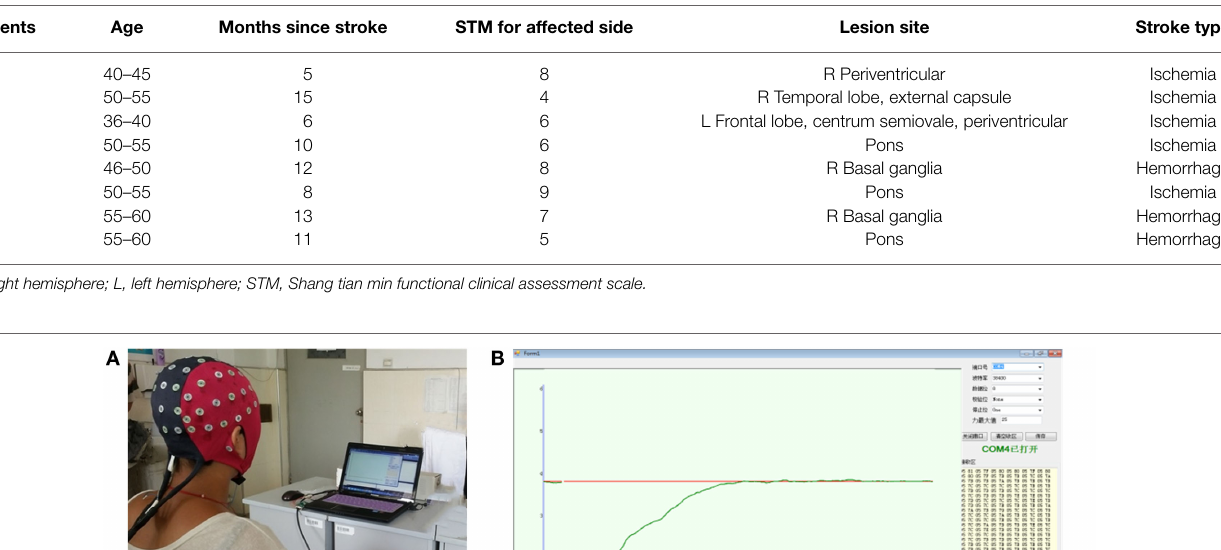
TABLE 1 | Demographic information of stroke patients.